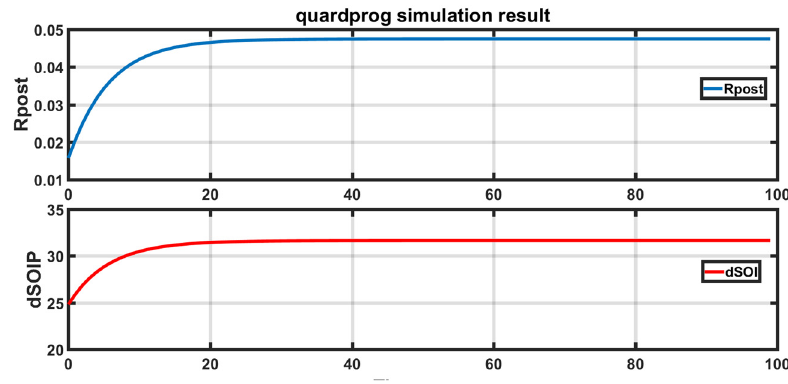
Figure 3: Simulation result system inputs from the quadprog solver.